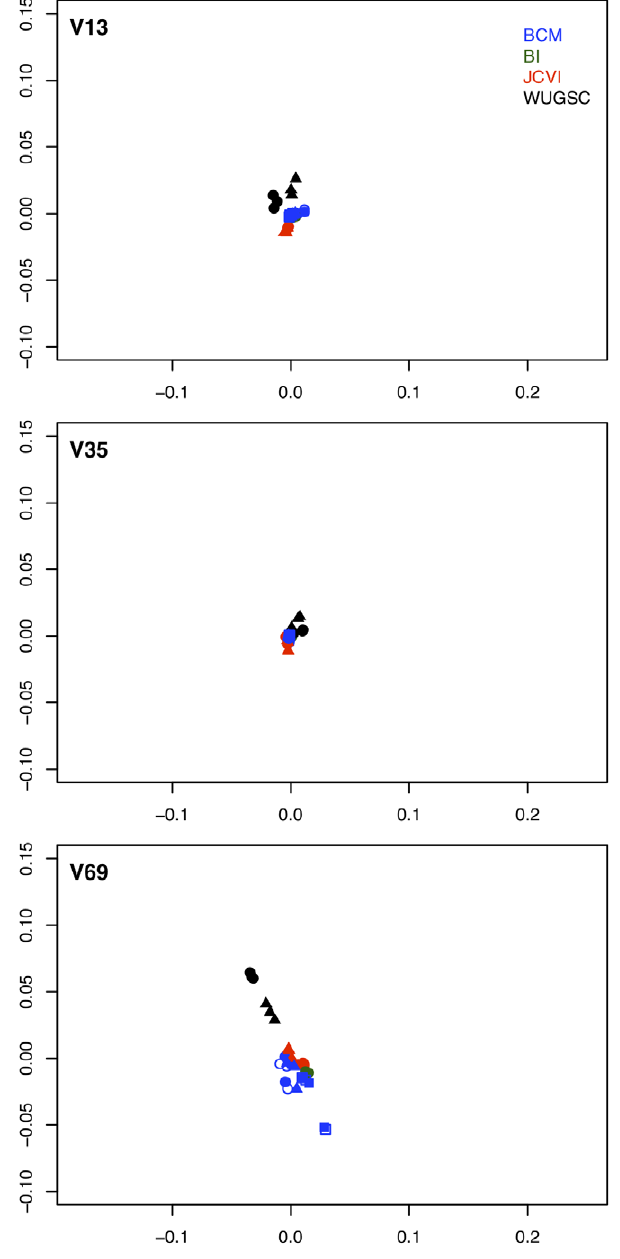
Figure 6. NMDS plot generated using ThetaYC distances between sequencing replicates of the same stool sample after standardizing the number of sequences per sample. Points with the same color and shape originated from the same sequencing